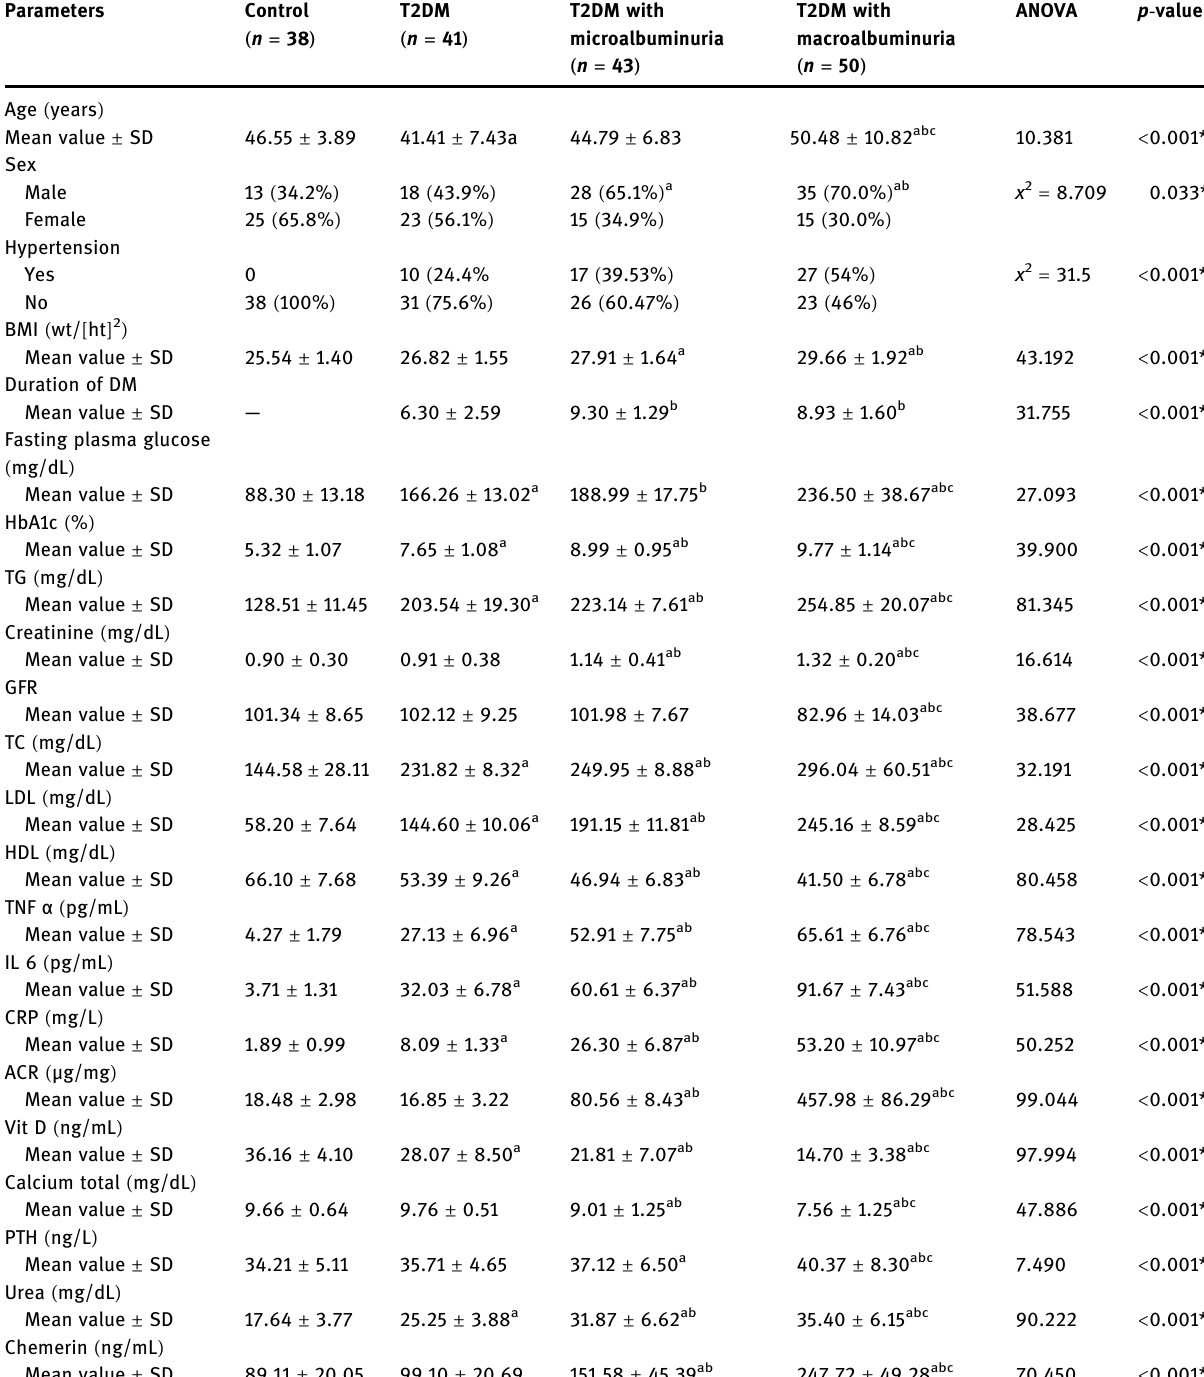
Table 1: Demographic and laboratory data of di ff erent studied groups Parameters